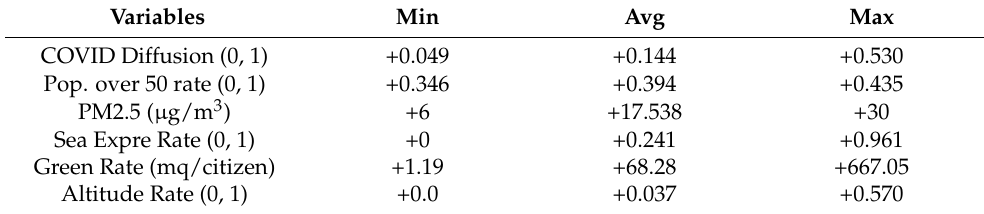
Table 1. Model parameters.